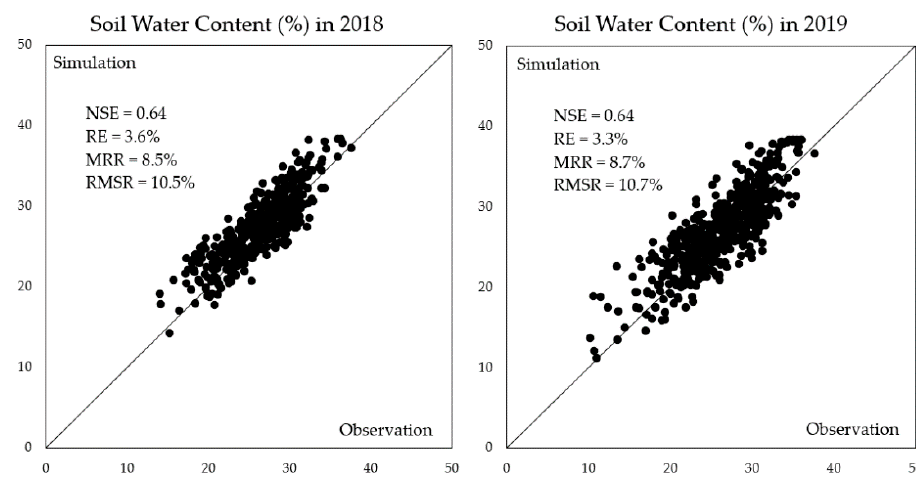
Figure 8. Comparison between simulated and observed soil water content.